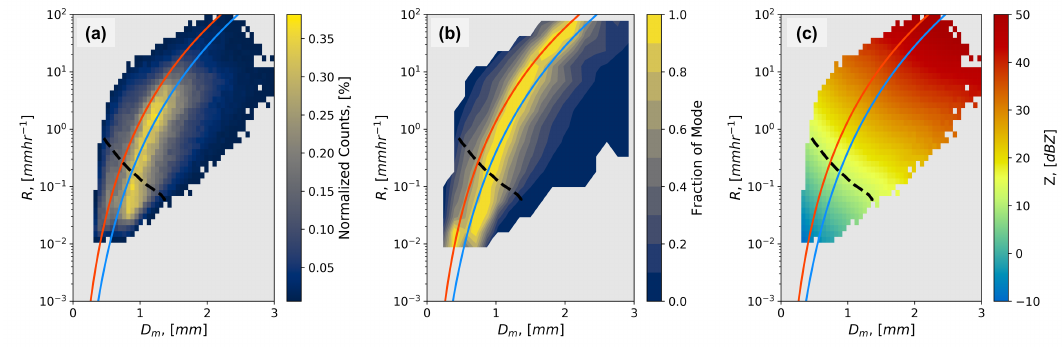
Figure 3. Investigating the relationship between R and D m from all the ground-based 2DVD disdrometers in rain. ( a ) Counts of observations on the R − D m plane normalized by the total number of observations and converted to percentages. Only bins with at least 10 observations are shown. The same relations of R − D m and the minimum sensitivity from Figure 2a are shown for reference. ( b ) Same data as ( a ), but the data are normalized to the total number of observations in each bin of R . A value near one implies that it is near the mode of observations in that bin of R . ( c ) Same 2D histogram as ( a ), but colored by the bin median value of Ku-band calculated Z e from the PSD assuming spheres and using a Tmatrix. Table 2. Error statistics for the entire 2DVD dataset. MAE: mean absolute error; MAPE: mean